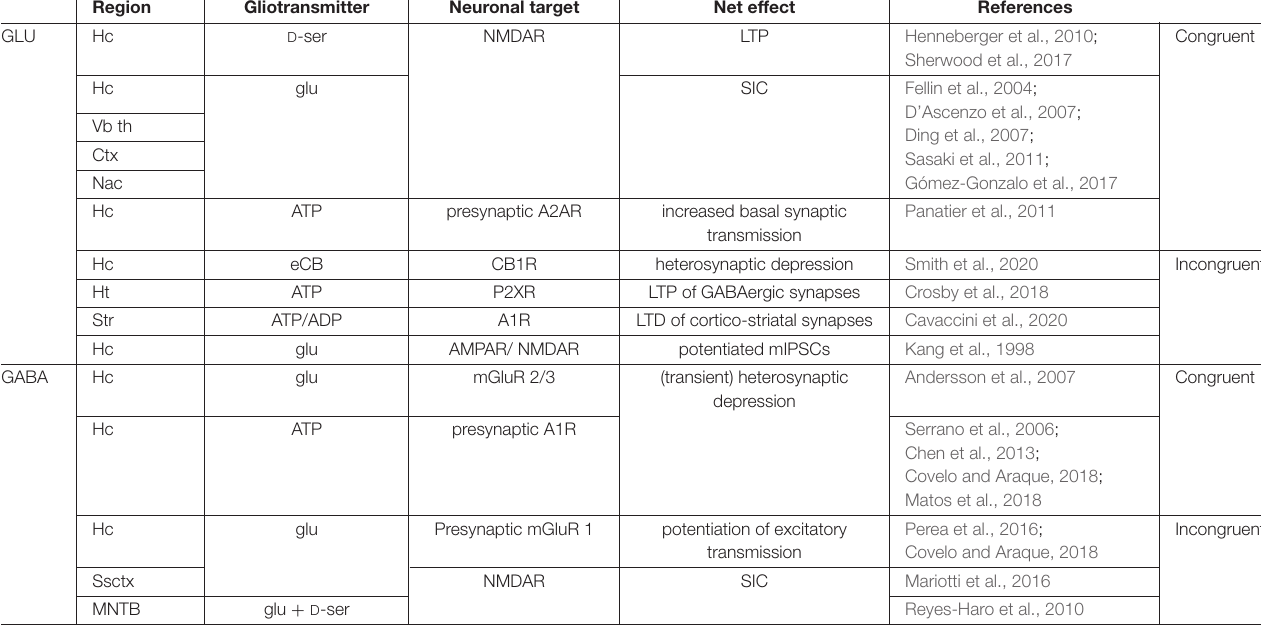
TABLE 1 | Summary of congruent and incongruent signaling pathways evoked by glutamate and GABA, according to brain region, released gliotransmitter, and principal neuronal